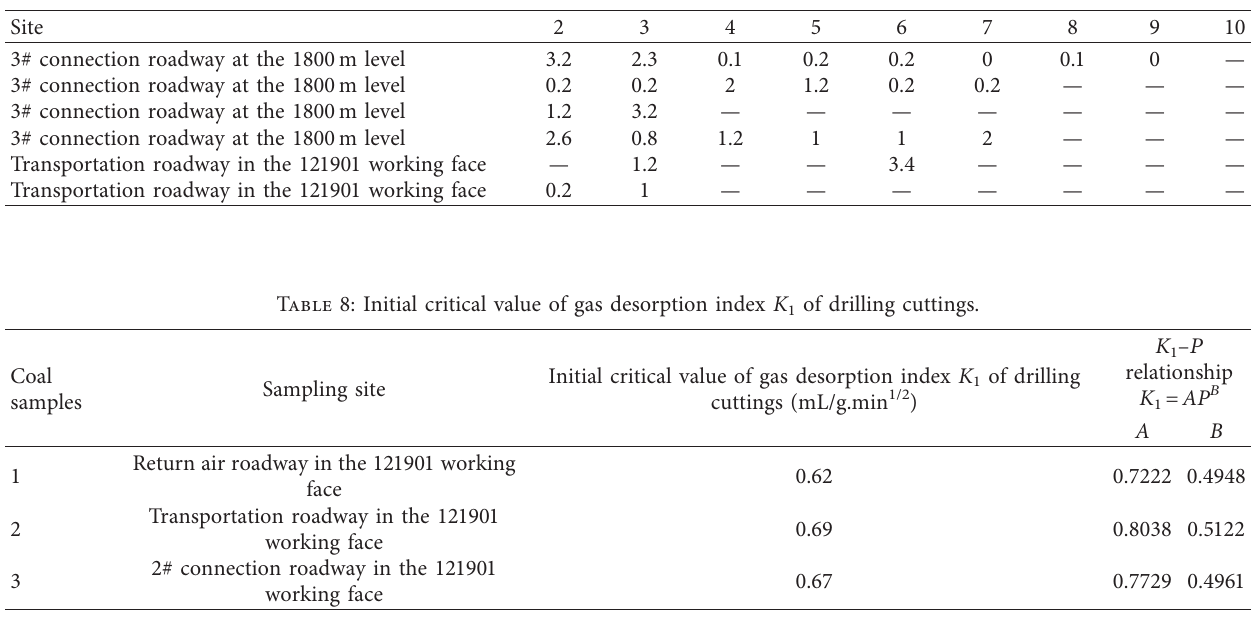
Table 7: Test of initial velocity q of gas emission.